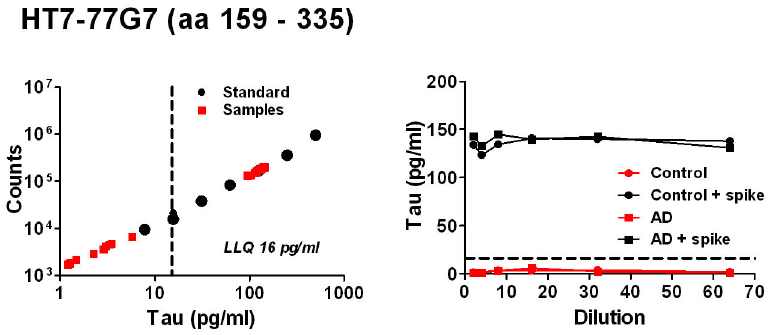
Figure 4. Characterization of HT7+77G7 tau ELISA. Representative tau 441 standard curve (left panel) and CSF dilution linearity results (right panel) shown. On the standard curve graph, tau 441 calibrators (Standards) and results for CSF sample dilutions (Samples) are shown. The assay lower limit of quantitation (LLQ, vertical dashed line) is also indicated. On the dilution linearity graph, tau levels for a pooled control and pooled AD CSF samples tested with or without a 100 pg/ml tau 441 spike are shown. doi: